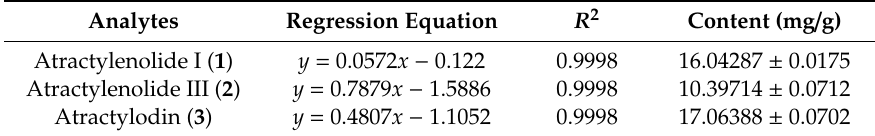
Table 1. Regression data and contents of three compounds in Atractylodis Rhizoma Alba ethanolic extract